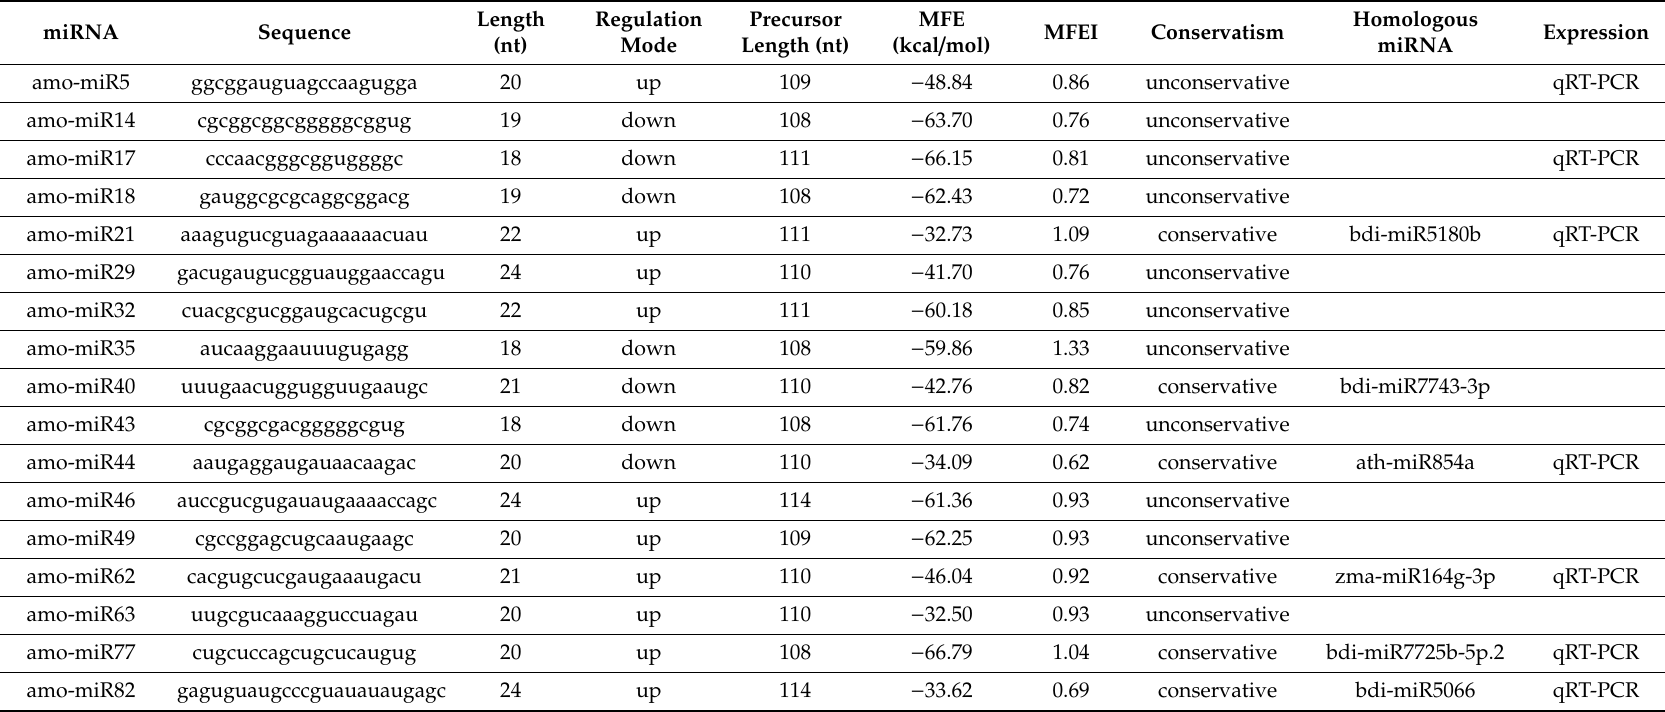
Table 4. Summary of 17 di ff erentially expressed miRNAs in A.